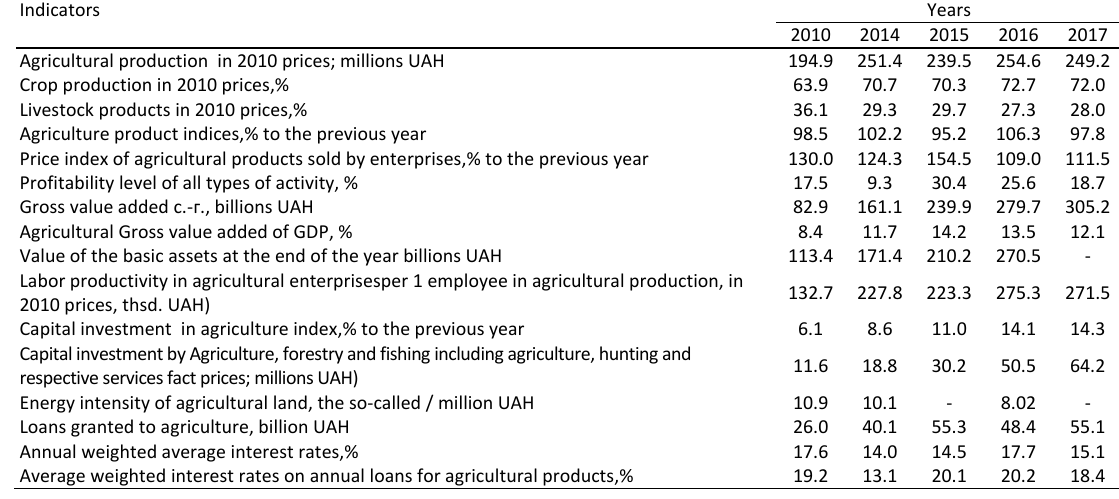
Table 5: Main indicators for agriculture in Ukraine for 2010, 2014-2017